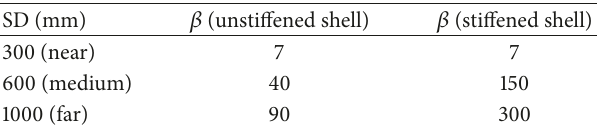
Table 1: Combination of various standoff distances (SD) and depth parameters ( 𝛽 ).